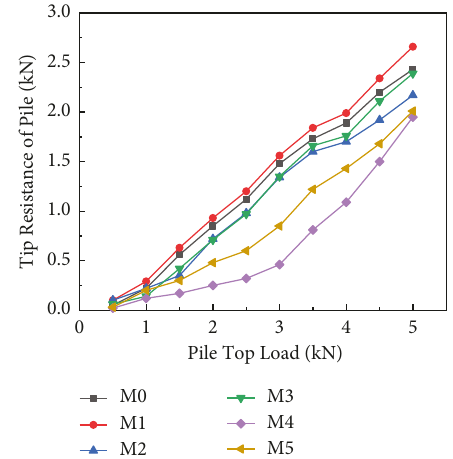
Figure 11: Curve of tip resistance and vertical load.